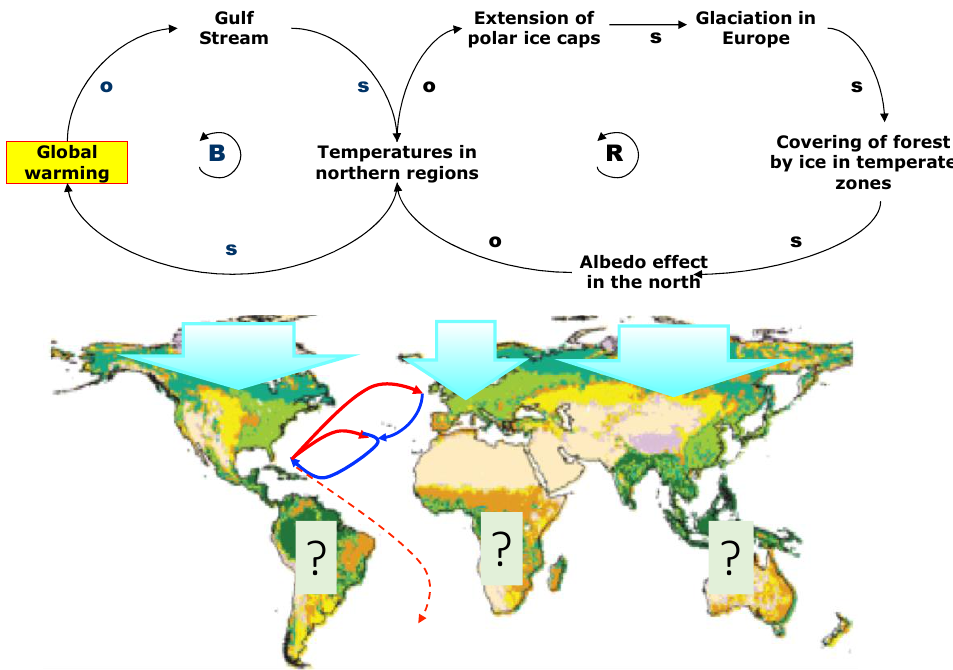
Figure 6. How the Daisyworld effect can control global warming.